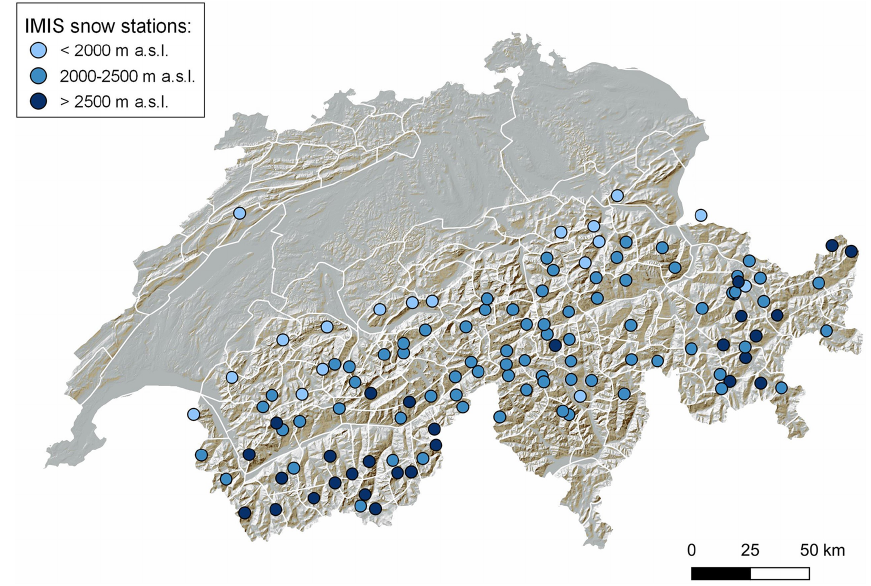
Figure 1. Snow stations of the IMIS network (points) located throughout the Swiss Alps (one station in northeastern Jura region) and the warning regions (white contours) used to communicate avalanche danger in the public avalanche forecast. Stations are coloured according to their elevation: below 2000ma.s.l., between 2000 and 2500ma.s.l., and above